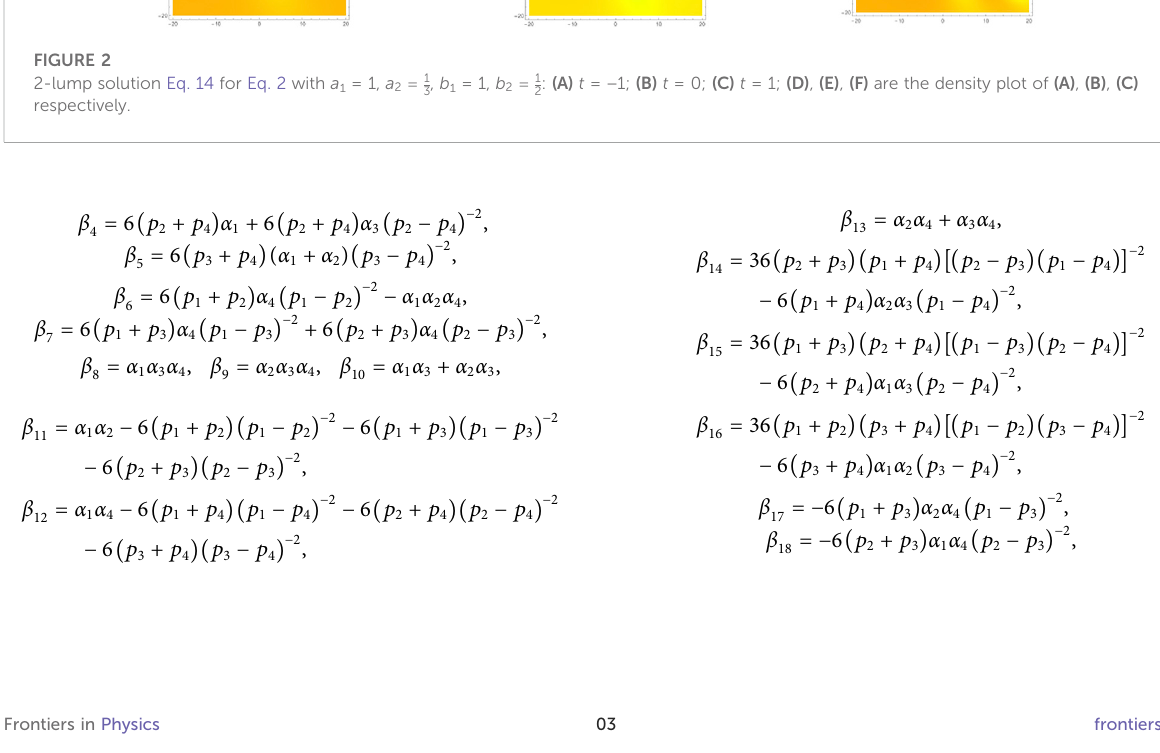
FIGURE 2 2-lump solution Eq. 14 for Eq. 2 with a 1 = 1, a 2 (cid:2) 1